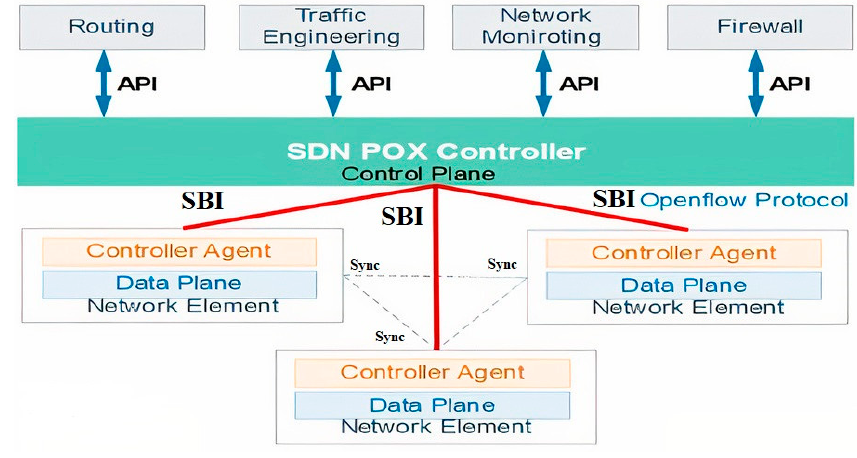
Figure 1. SDN Architecture.